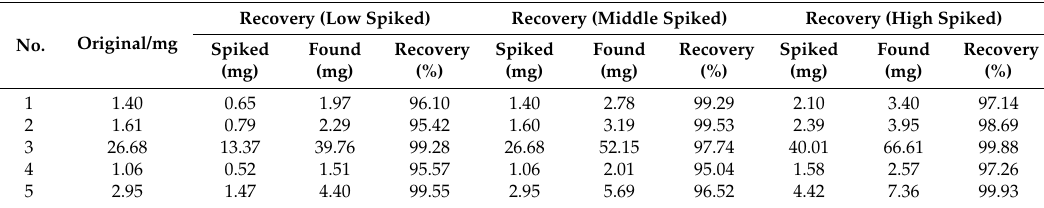
Table 4. Extraction recoveries of the five